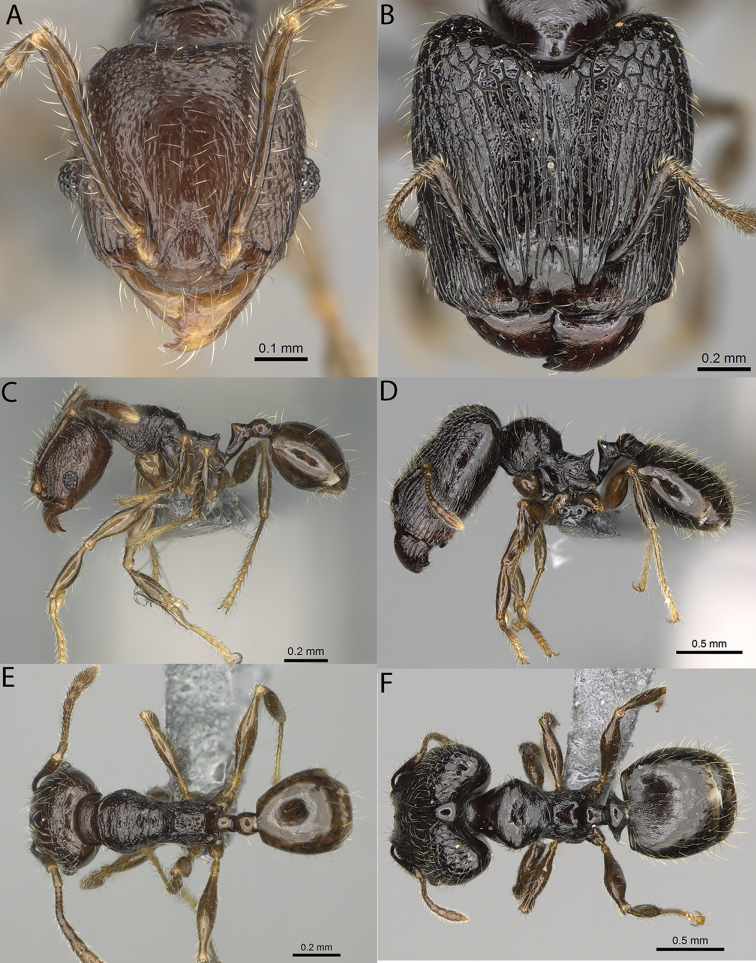
Pheidole
lamperos sp. nov., full-face view (A), profile (C), and dorsal view (E) of paratype minor worker (CASENT0923181) and full-face view (B), profile (D), and dorsal view (F) of holotype major worker (CASENT0300132).